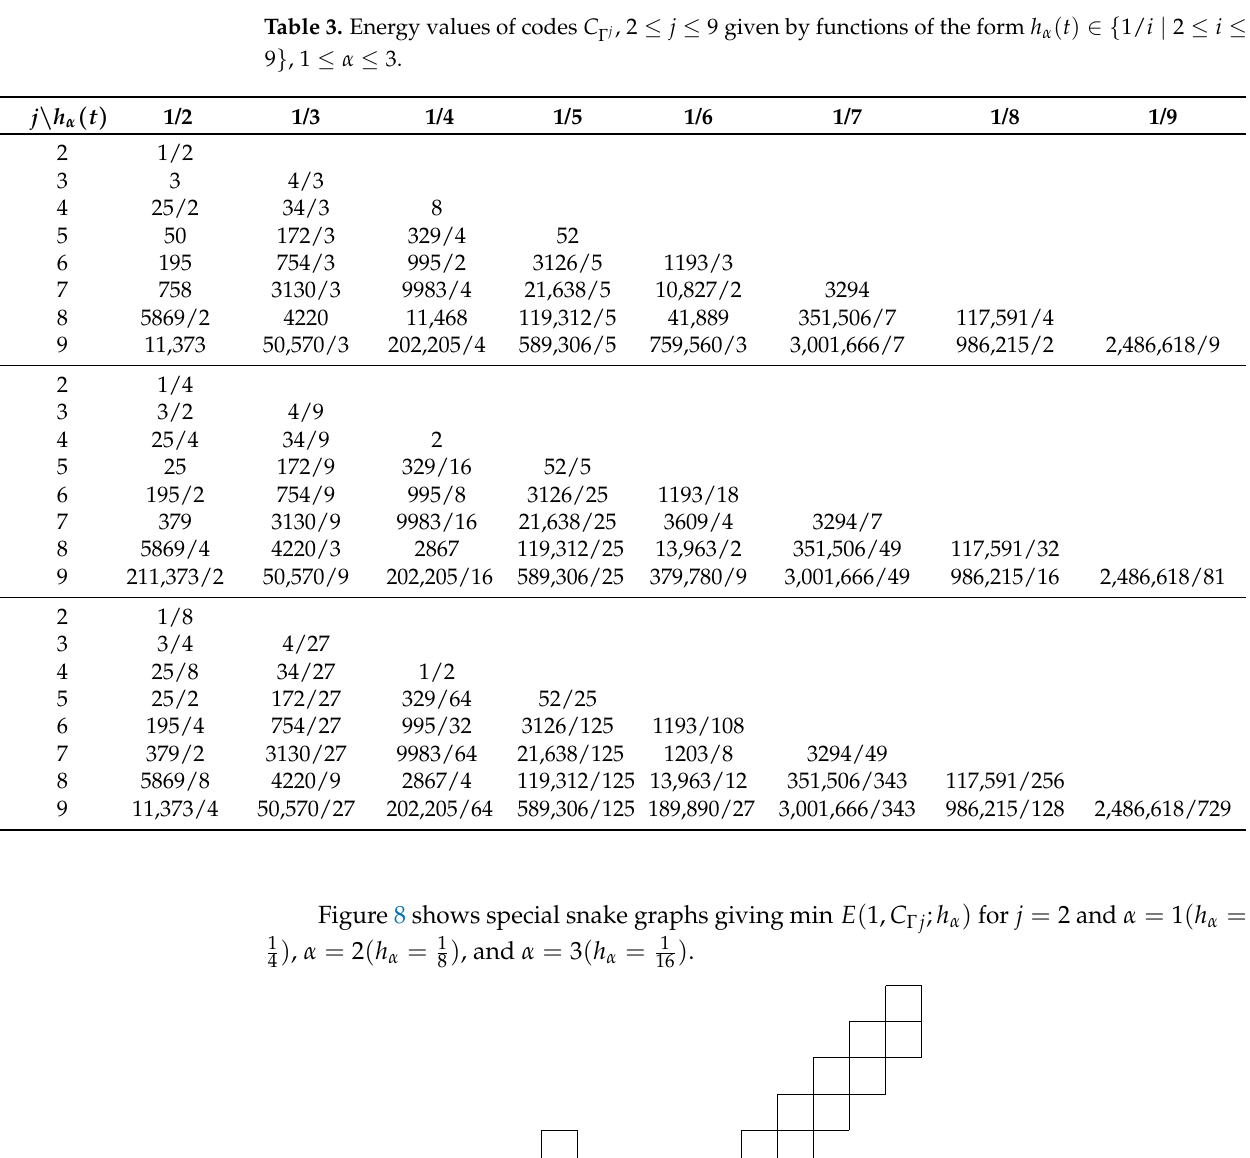
9 given by functions of the form h α ( t ) j ≤ ≤